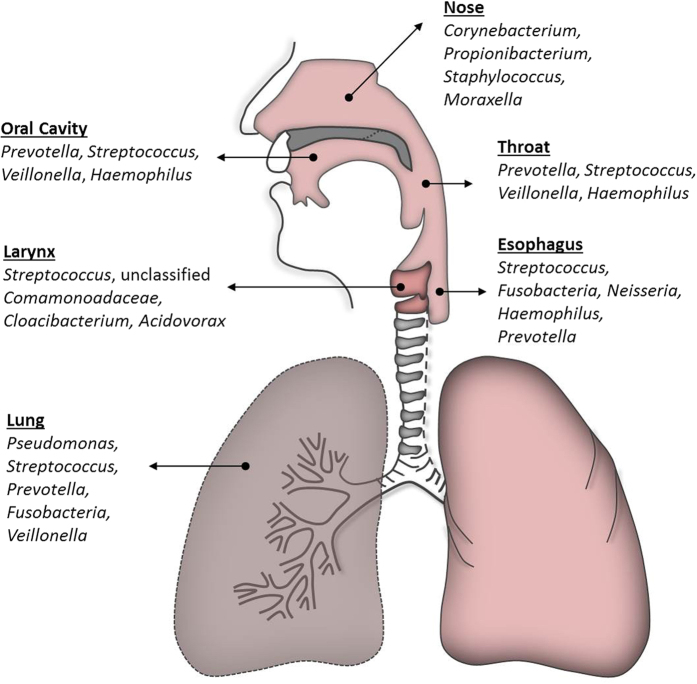
Schematic outlining common microbes across the aerodigestive tract101112,282930,50,62.